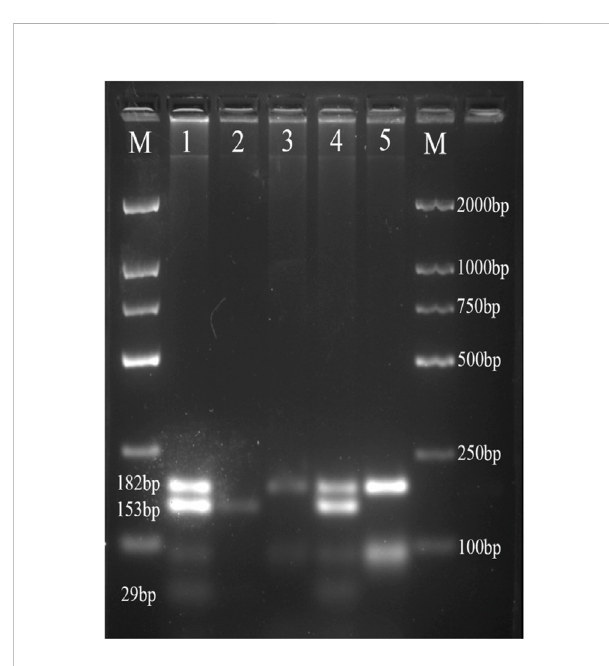
FIGURE 2 Agarose gel picture showing digested PCR products for FABP1 gene polymorphism. M, marker; 1 and 4 show Thr/Ala genotype; 2 shows Ala/Ala genotype; 3 and 5 shows Thr/Thr genotype.